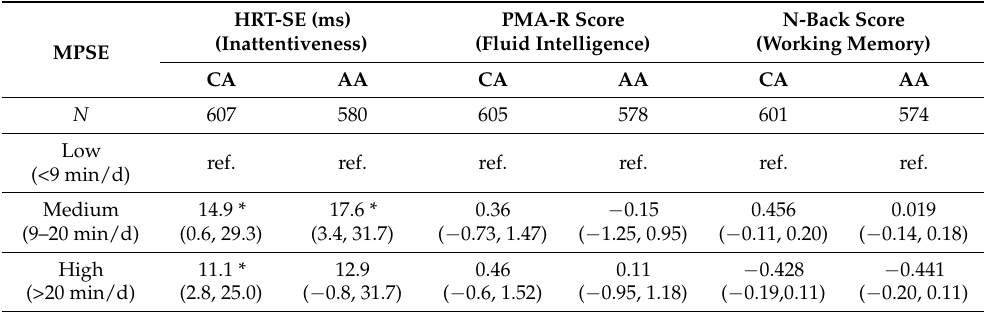
Table 3. Association between mobile phone screen exposure and cognitive outcomes, adjusting and not for confounders.